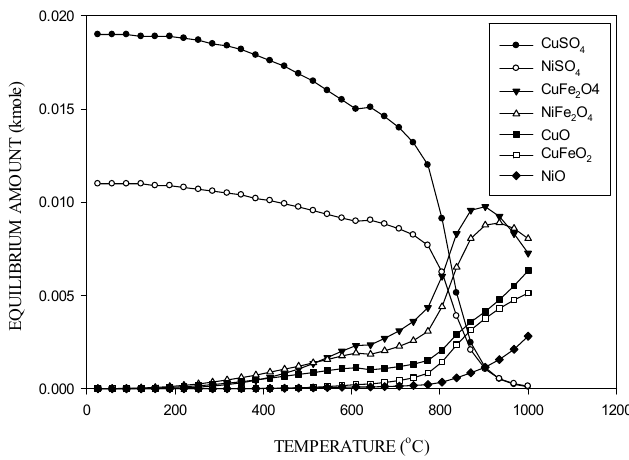
Figure 8. Behaviours of copper- and nickel-containing species as a function of temperature for a sulphur dioxide addition of 0.68 kmole/100 kg of dust and 0.4 kmole of oxygen/100 kg of dust.